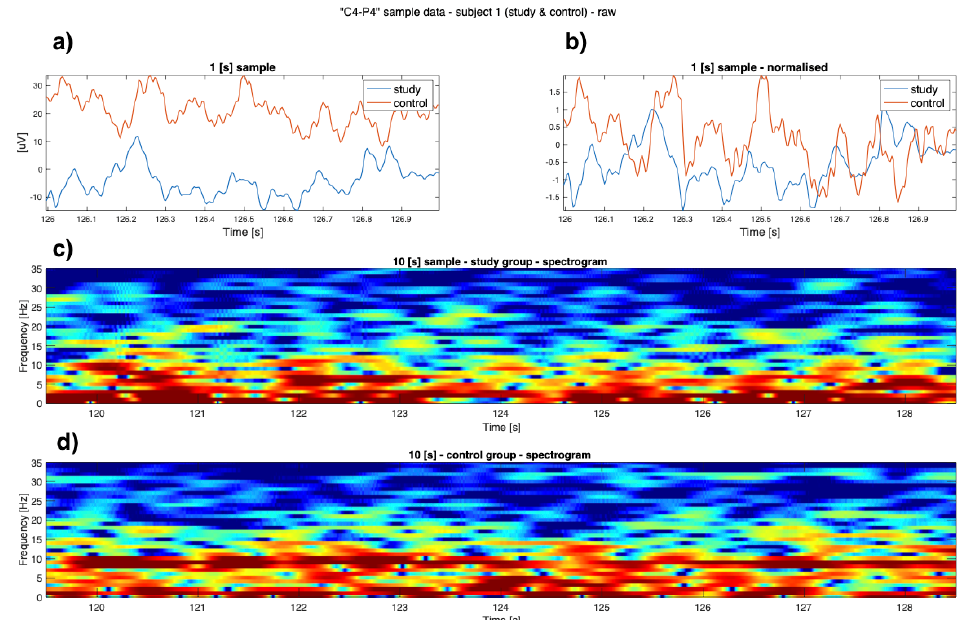
Figure 3. Example raw data from channel ’C4-P4’ : ( a ) time-series of both study group and control group (1 [s]); ( b ) normalised time series of study group and control group (1 [s]); ( c ) 10 [s] sample of FASD (top spectrogram); ( d ) 10 [s] of healthy control (bottom spectrogram)—sample 1.